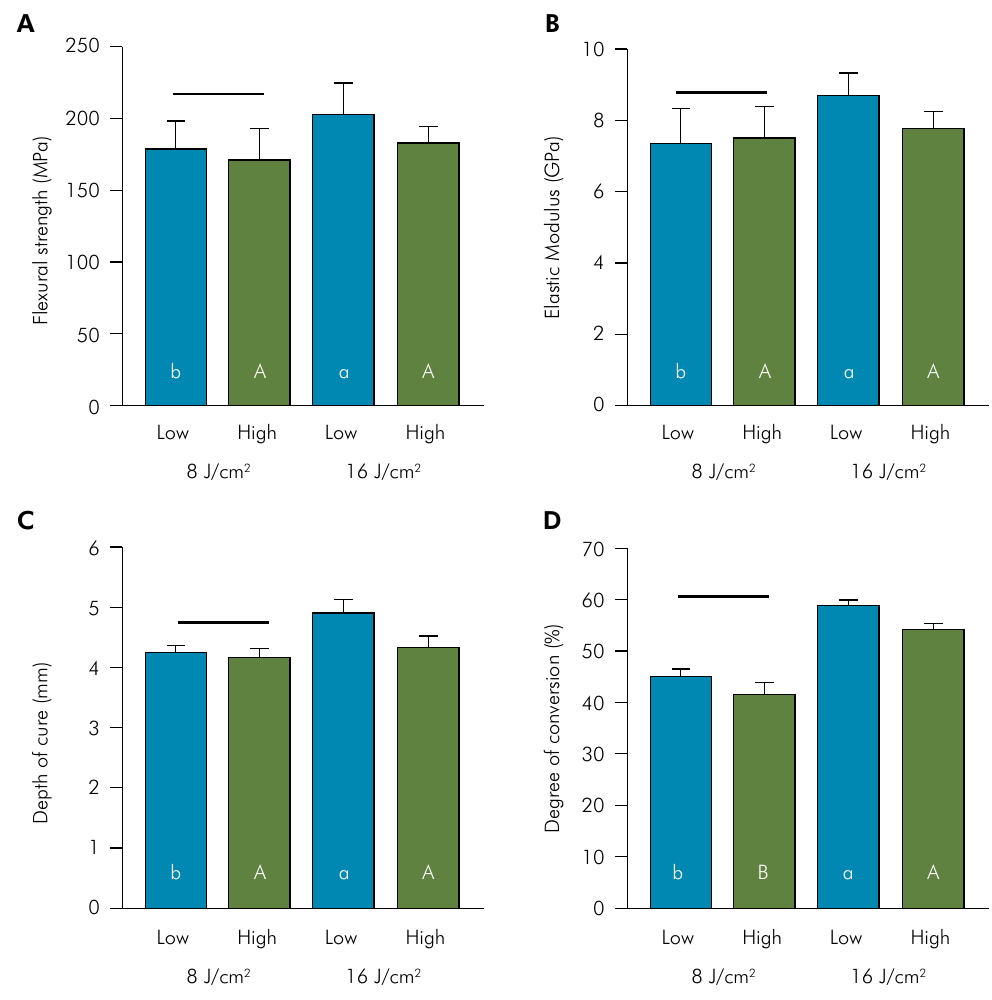
Figure 2. Flexural Strength (A), elastic modulus (B), depth of cure (C), and degree of conversion (D) of the micro-hybrid composite as the functions of irradiance and radiant exposure are represented in bar charts. For each chart, bars connected by the same horizontal line represent no differences between the groups (irradiance for each radiant exposure). Different lowercase and capital letters indicate the differences between the blue and red charts,